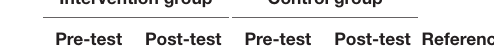
TABLE 3 | Ratios of different core exercises before and after the intervention ± standard deviation. Intervention group Control